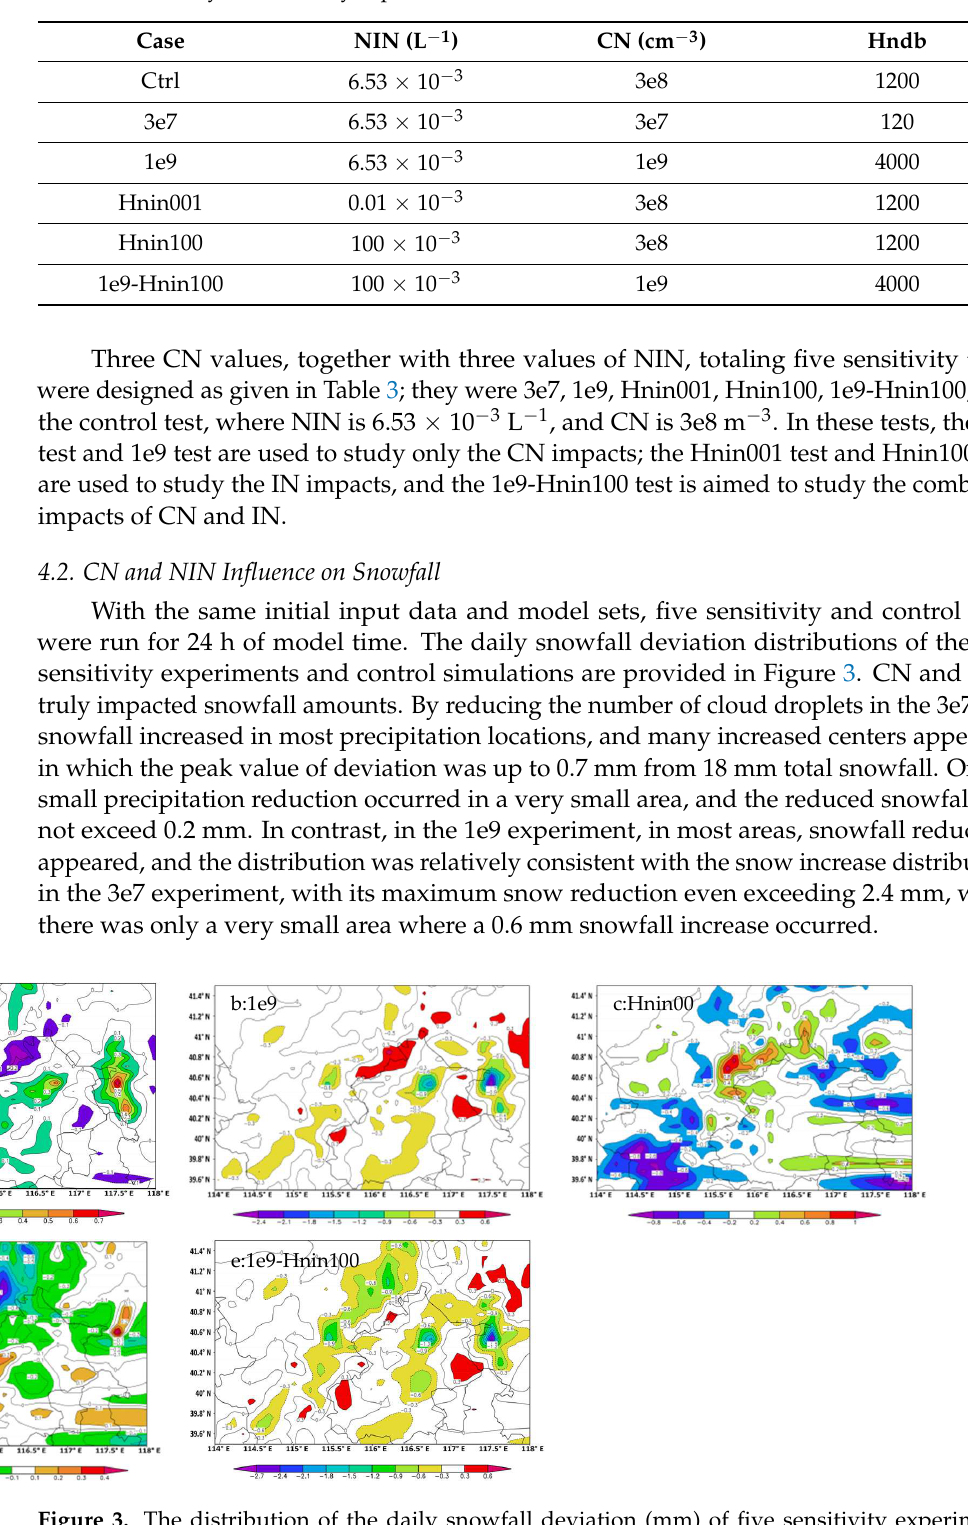
Table 3. Summary of sensitivity experiments of CN and NIN.